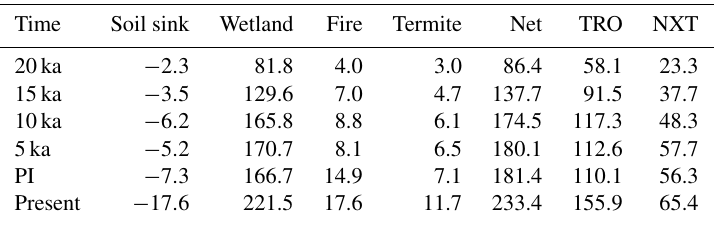
Table 2. Methane emissions for all time slices (in TgCH 4 yr − 1 ). Shown are soil uptake, total wetland emissions, fire and termite emissions, net emissions, and wetland emissions from TRO and NXT. Time Soil sink Wetland Fire Termite